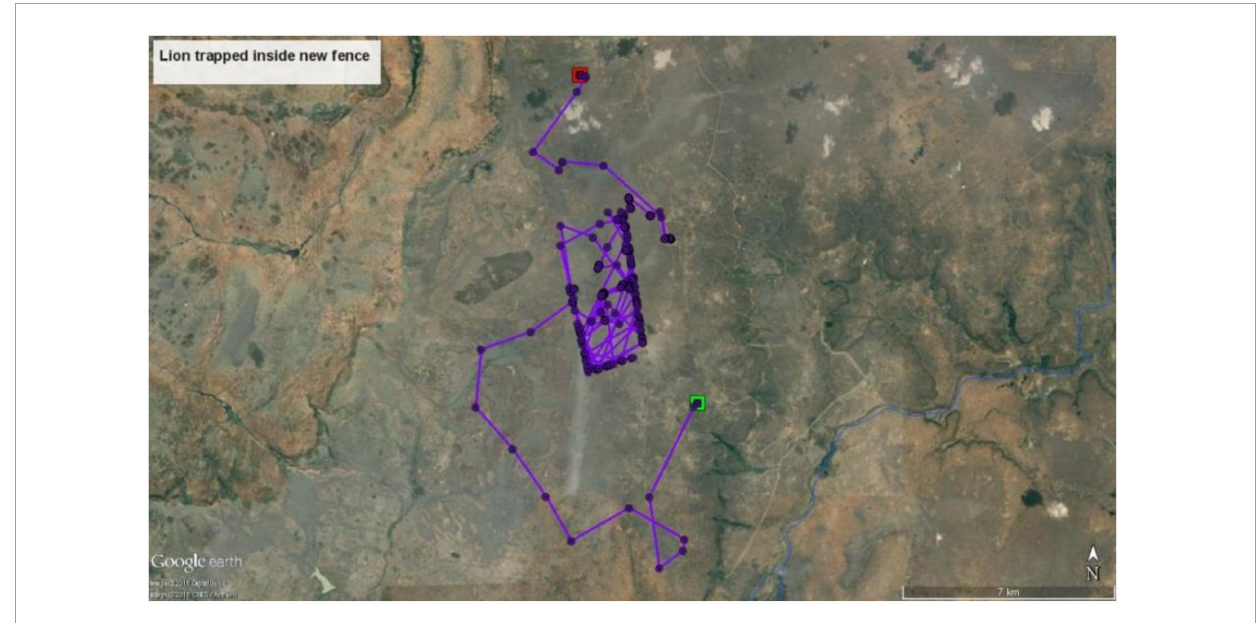
FIGURE7 Global positioning system (GPS) collar data from a male lion trapped inside a newly constructed fence. When he was seen to be moving in a rectangle, he was immobilized and released outside the fence. He had lost 50 kg while